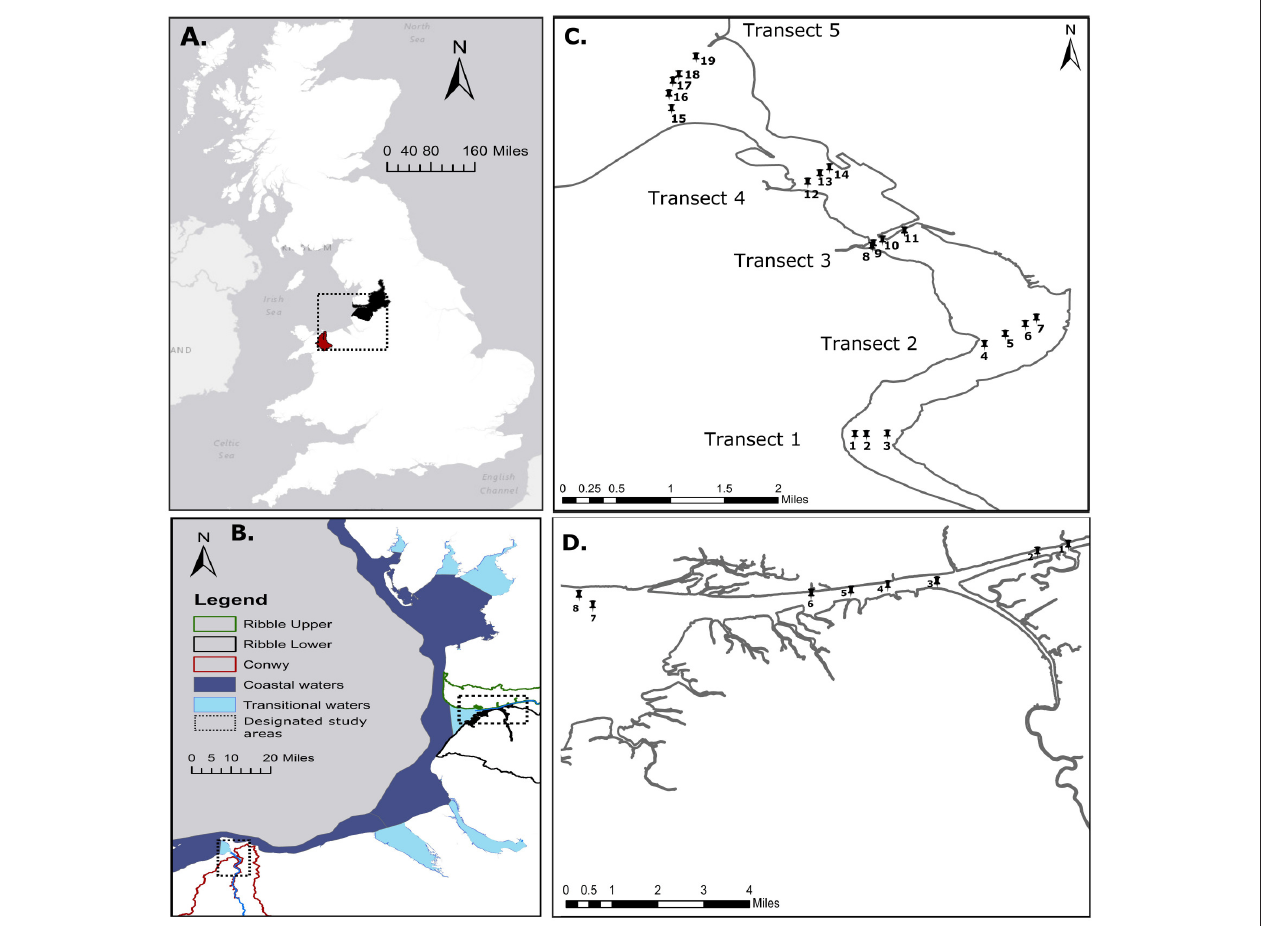
FIGURE 1 | Study locations. (A) Catchment scale Conwy, Wales, UK and Ribble, England, UK. (B) North West UK coastal and transitional waters are shown (2006/7/EC) and designated estuarine study locations (black box) are indicated. (C) Conwy Estuary with five transverse transects with water and sediment collected at nineteen samples sites. (D) Ribble Estuary with water and sediment collected at eighth sample sites. Conwy catchment and Ribble Upper and Lower catchments are shown.